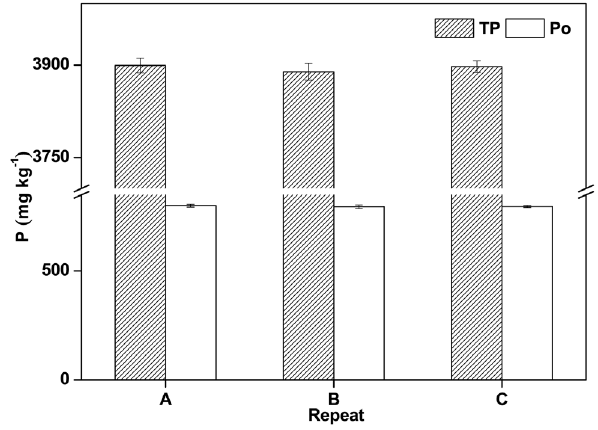
Figure 6. The total P (TP) and organic P (Po) concentrations in the re-dissolved extracts after lyophilization.